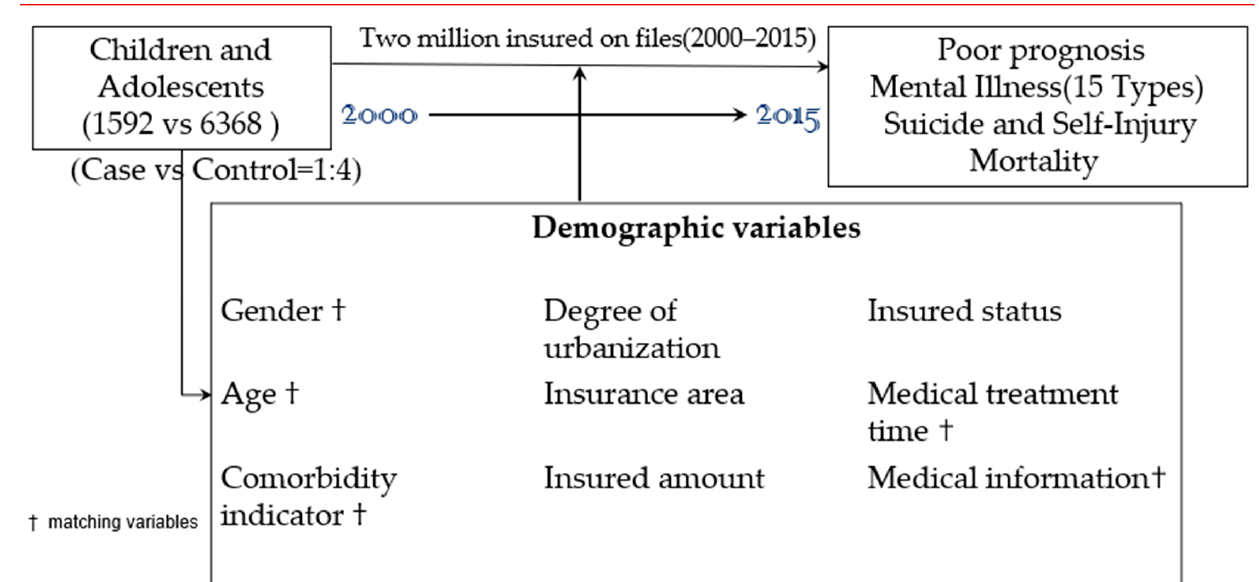
Figure 1. The flowchart of the study sample selection.